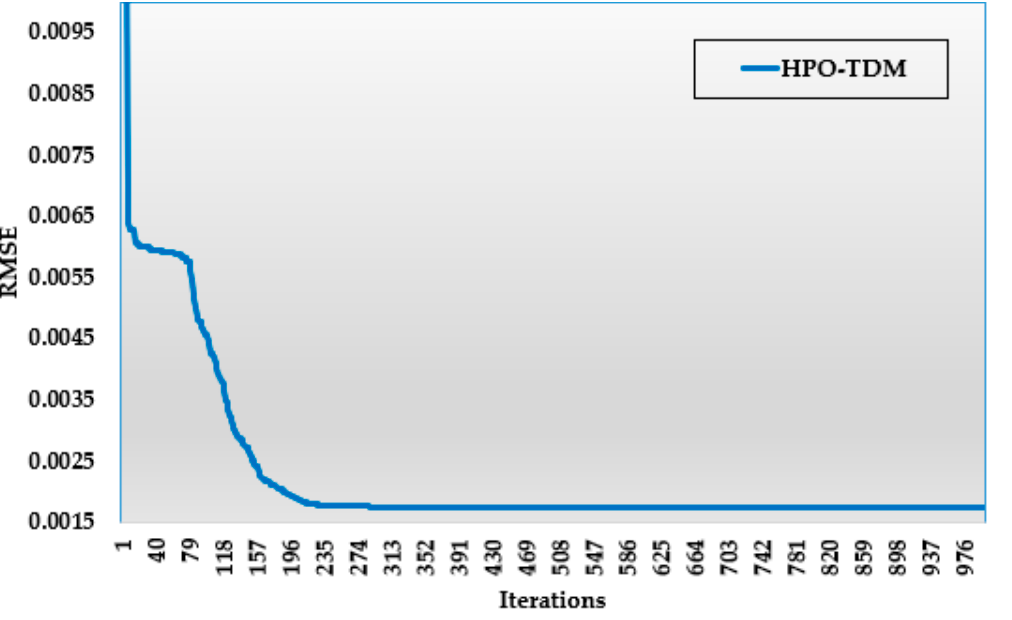
Figure 10. Convergence trend of the proposed HPO technique for triple-diode model of STM6_40/36 PV module.